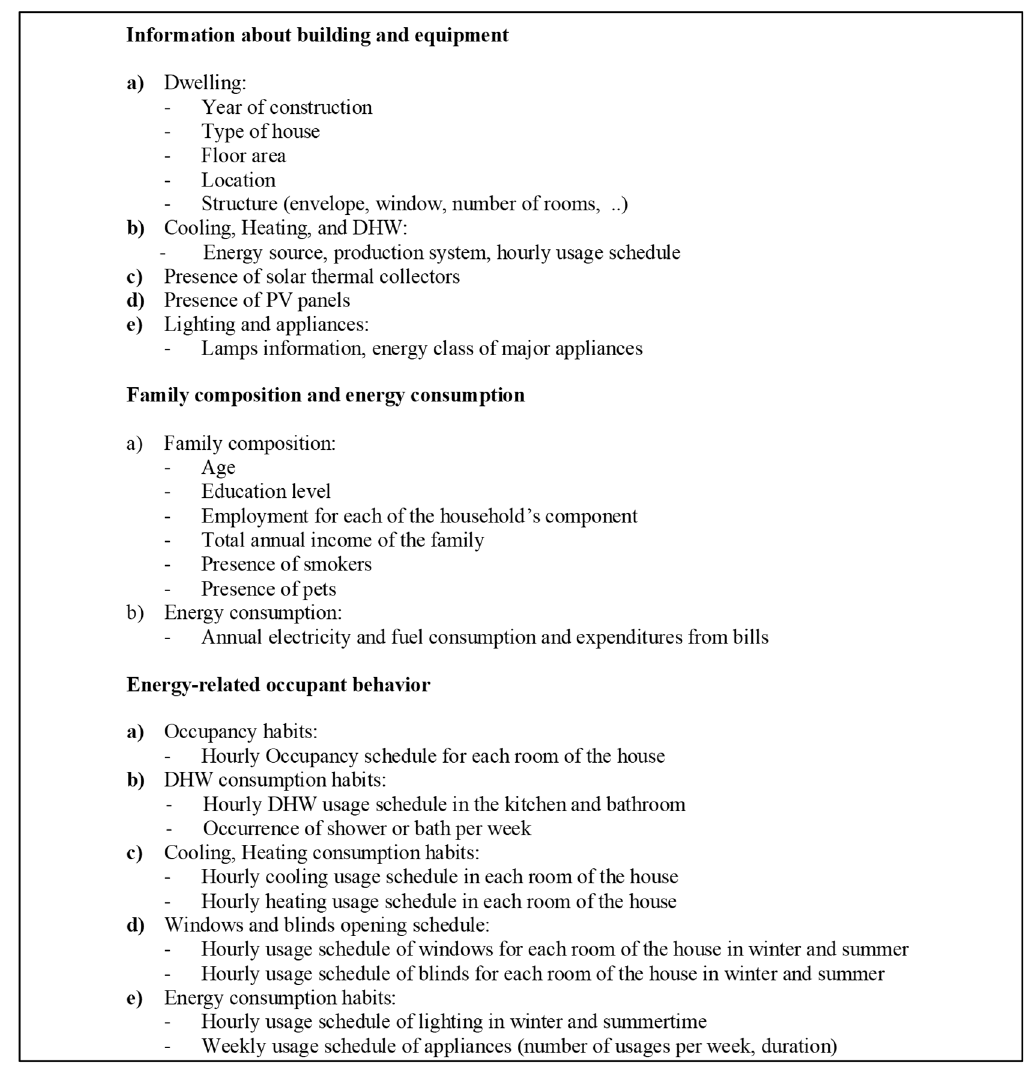
Figure 2. Questionnaire contents.